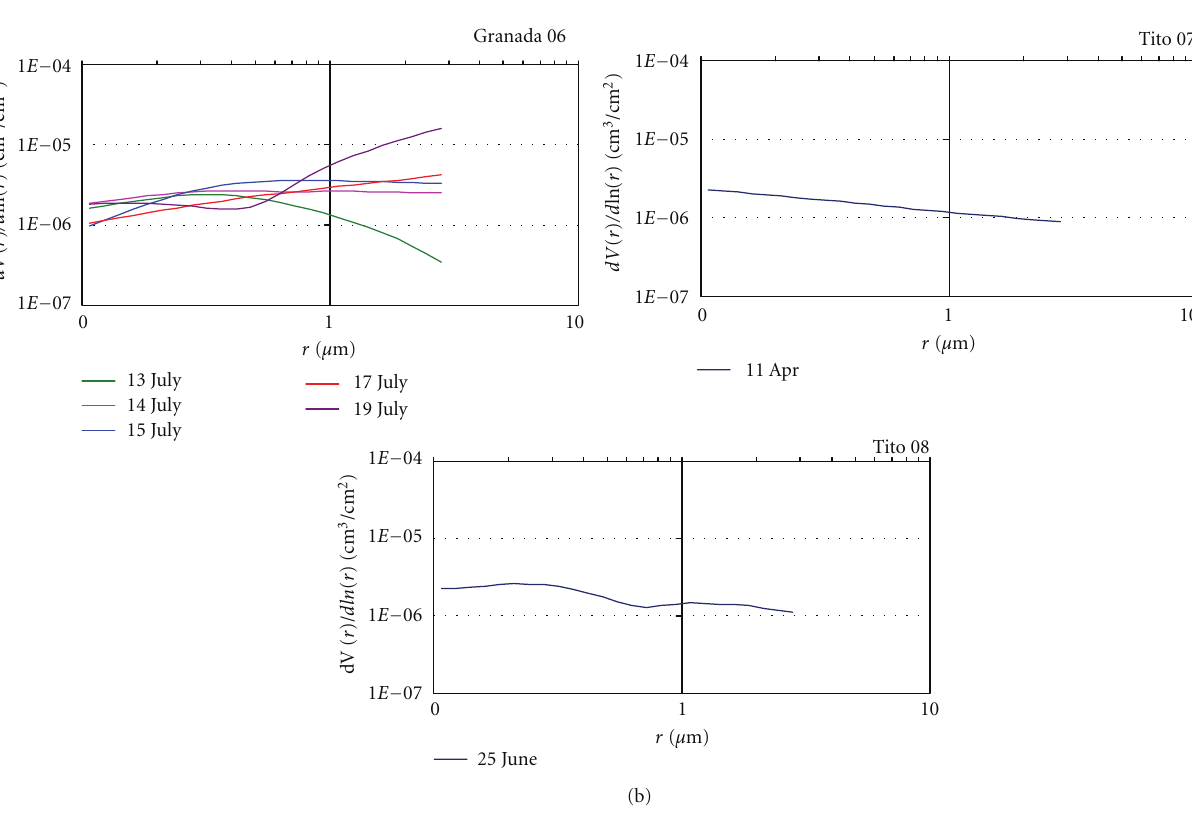
NOAA HYSPLIT model Backward trajectories ending at 10 UTC 28 May 08 GDAS meteorological data